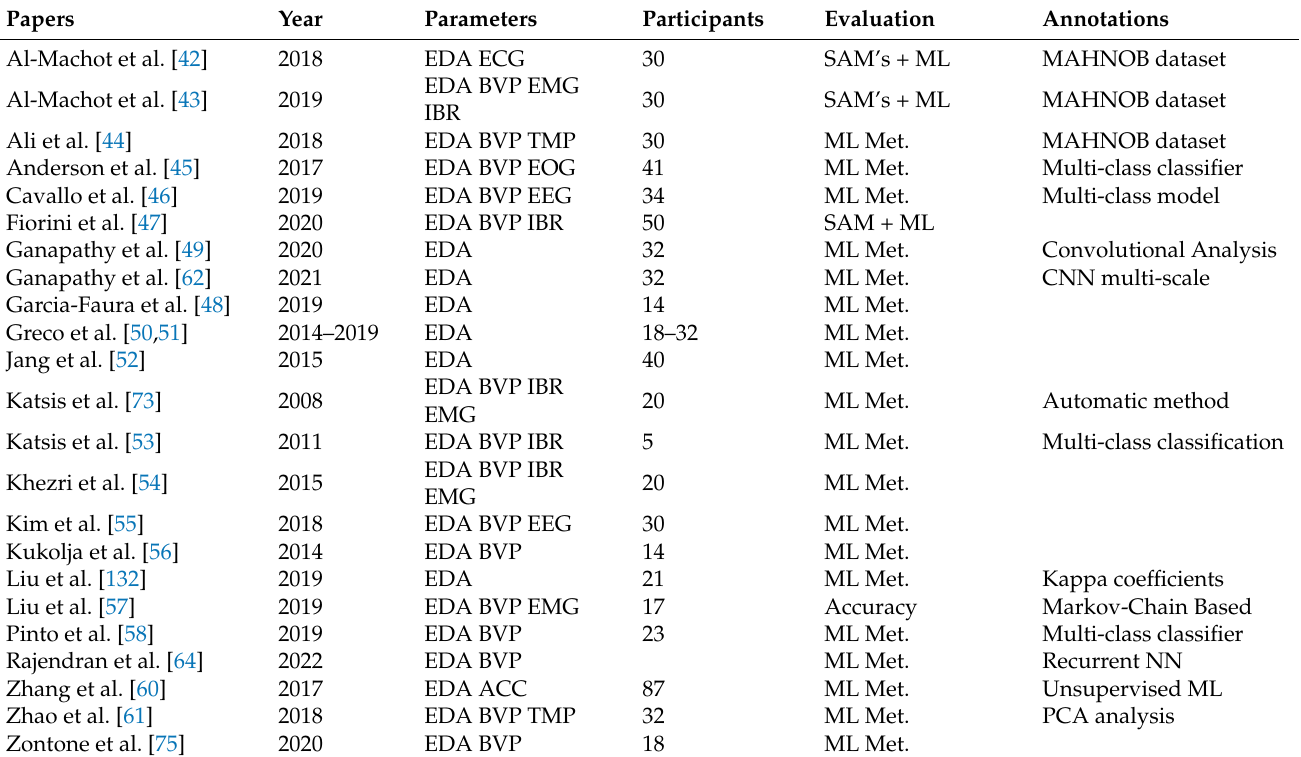
Table 6. Physiological signals used for emotion detection.